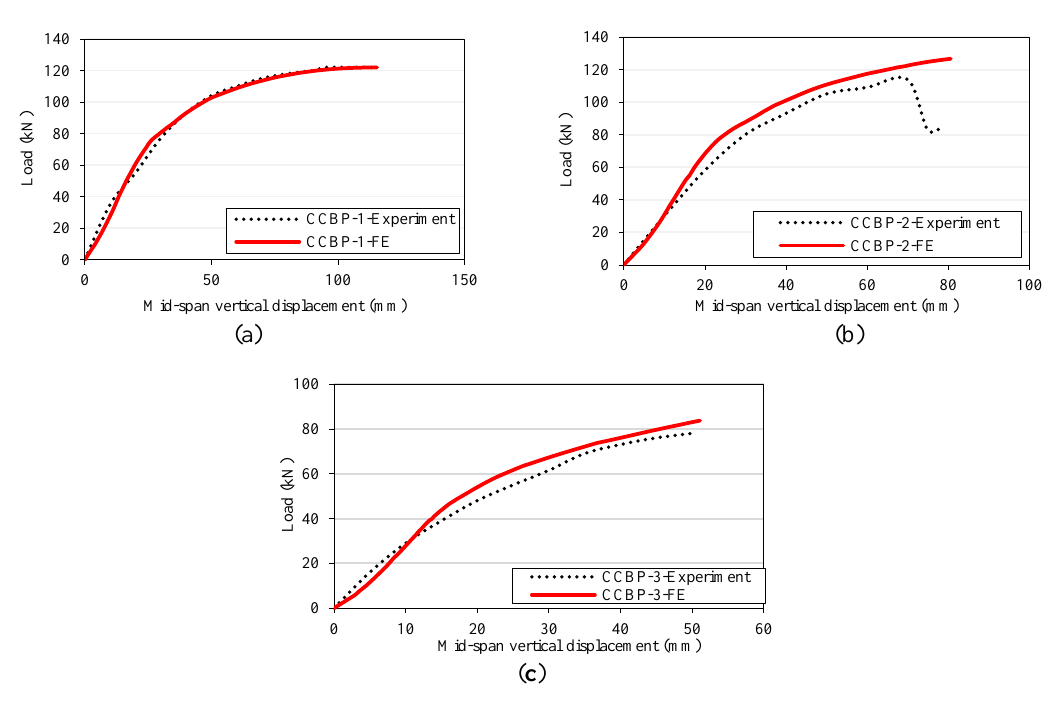
Figure 7. Comparison of the theoretical and experimental load-displacement: (a) Specimen CCBP-1; (b)